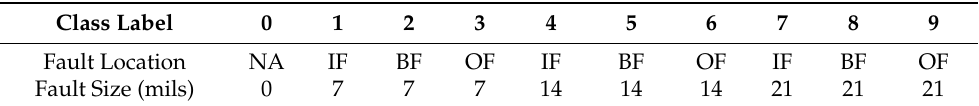
Table 5. The task of the CWRU